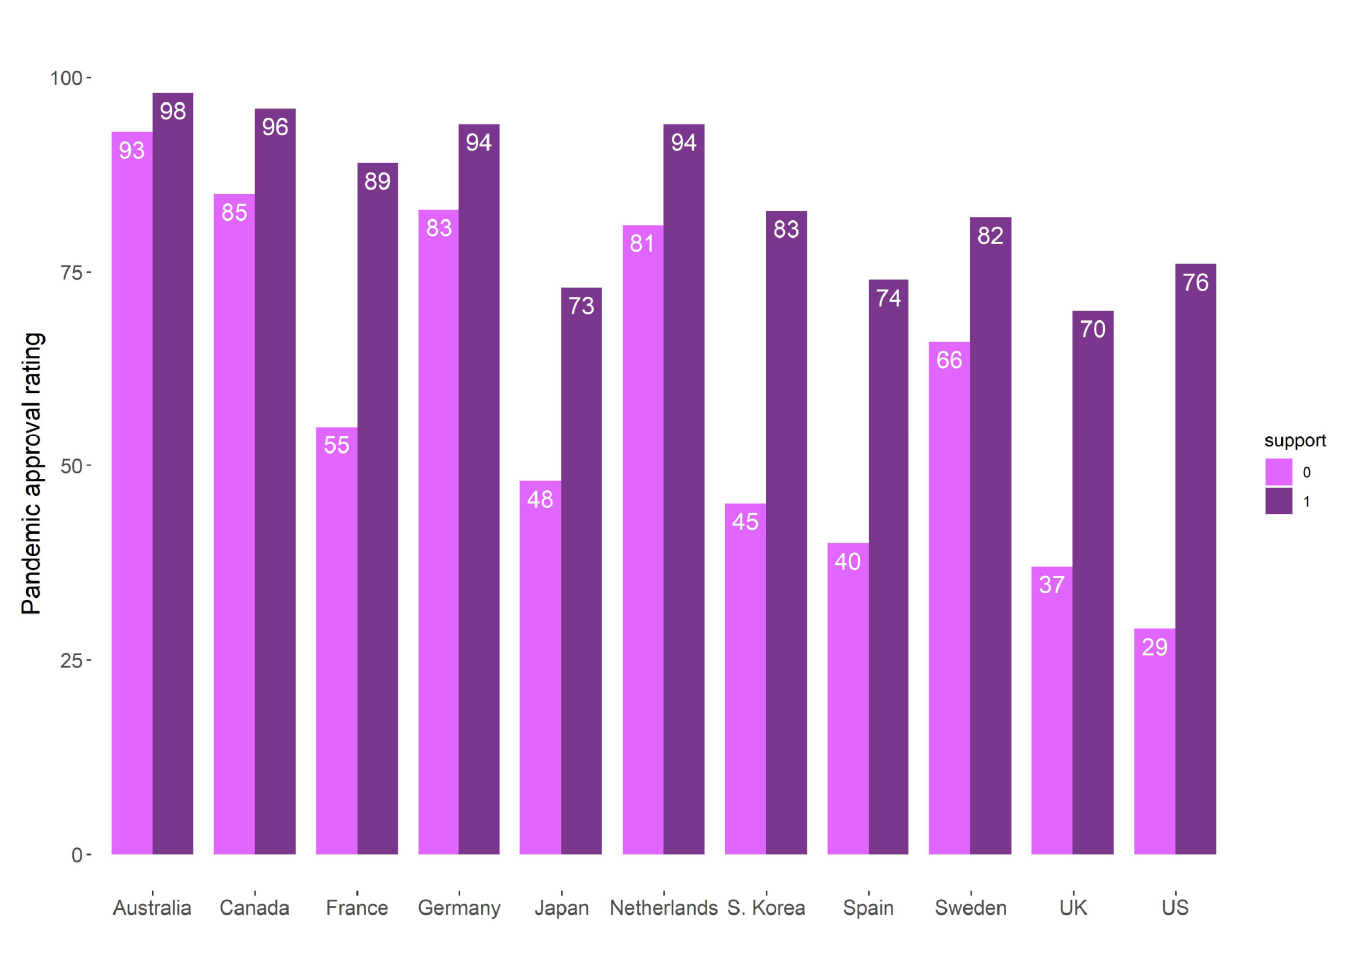
Fig 1. Approval ratings of respondents who “say their country has dealt with the COVID-19 outbreak well” grouped by governing party supporters (1) and non- supporters (0).